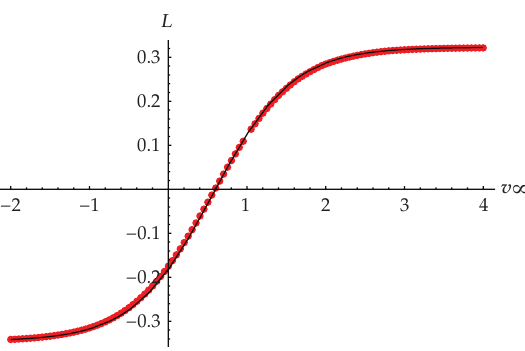
Figure 12: Regularised proper length L reg , or equivalently, the entanglement entropy S A , as a function of the boundary v ∞ , for the particular region (cid:3) an arc of fixed length along the spatial direction (cid:4) in the Vaidya spacetime (cid:3) red dots (cid:4) and the corresponding analytic prediction in BTZ (cid:3) black curve (cid:4) .